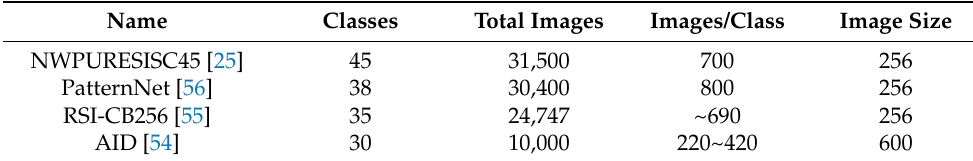
Table 1. Description of the dataset for the experimental